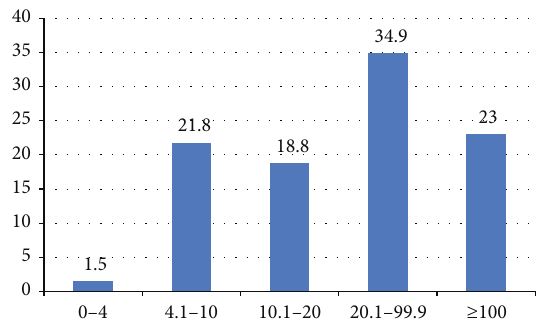
Figure 2: Distribution of PSA values among patients with prostate cancer, 𝑛 = 261